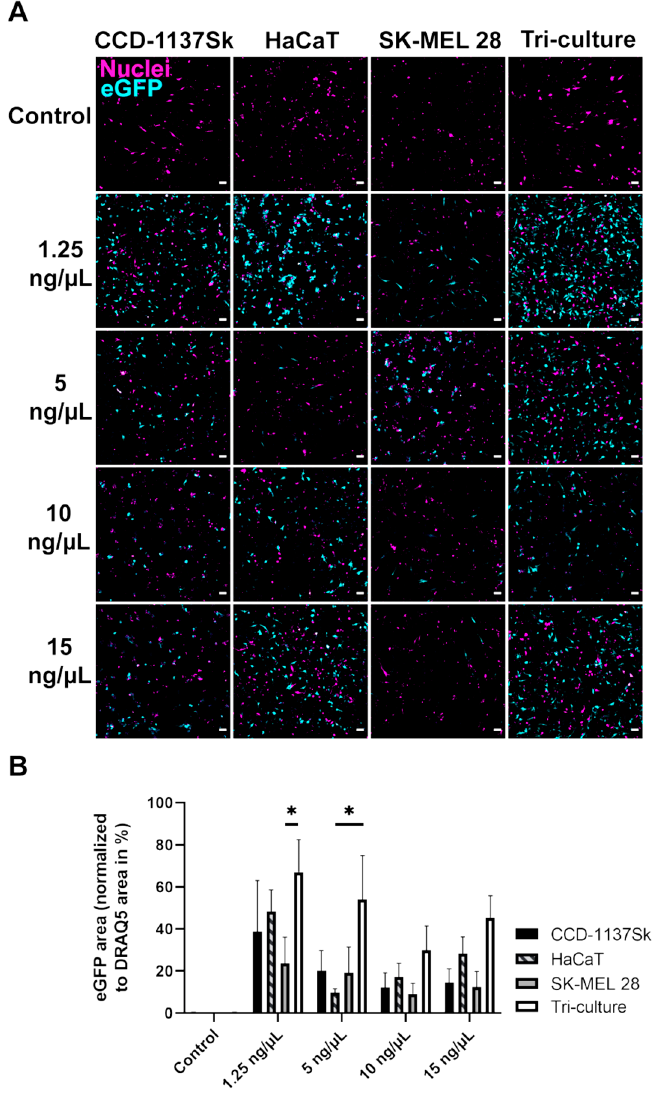
Figure 2. Lipoplex-mediated eGFP translation is enhanced in adherent tricultures of CCD-1137Sk, HaCaT, and SK-MEL 28 cells, compared to corresponding monocultures. For each culture condition, a total number of 3 × 10 4 cells was seeded. The cell number and viability were determined by Vi-CELL XR. After 24 h, treatment with varying dosages of eGFP LPX or with PBS (control). Afterwards, cells were fixed and stained for nuclei. Confocal microscopy was used to visualize nuclei (magenta) and eGFP (cyan). ( A ) Representative confocal multi-tile scans are shown. Scale bars, 100 µ m. ( B ) Quantitative analysis of the eGFP area normalized to nuclei signal area as a function of LPX amount added (0 to 15 ng/ µ L). Mean + SD ( n = 3 independent experiments). Two-way ANOVA